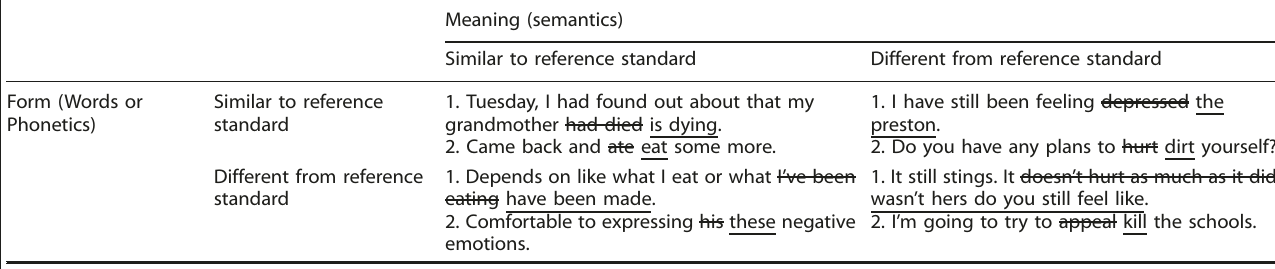
Table 4. Transcription errors made by the automatic speech recognition